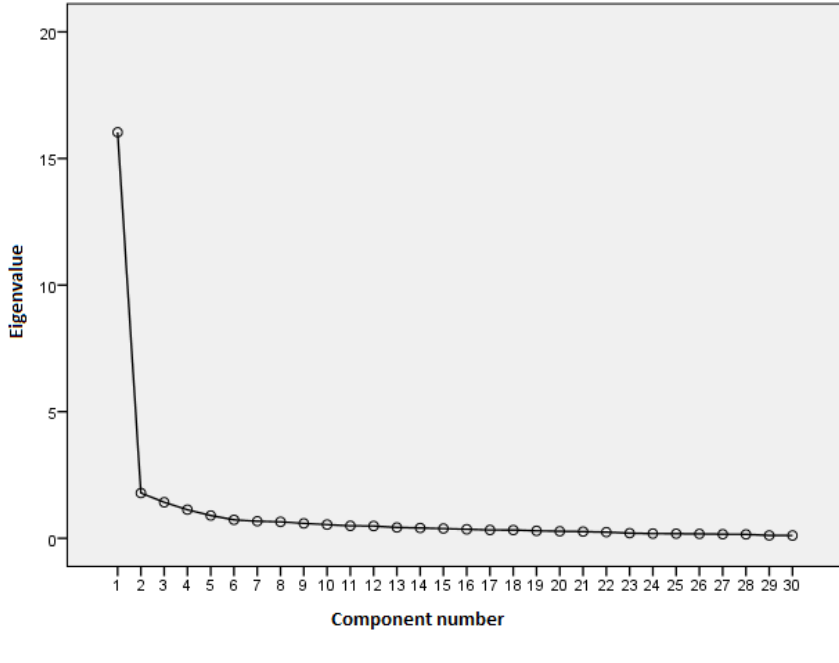
Figure 1. Scree Plot for the original 30